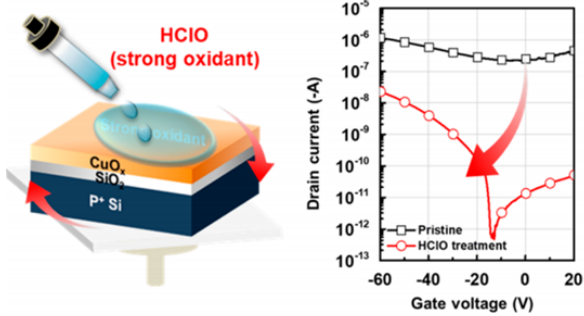
Figure 8: Transfer characteristics of the CuO x TFT with HClO treat- ment [59]